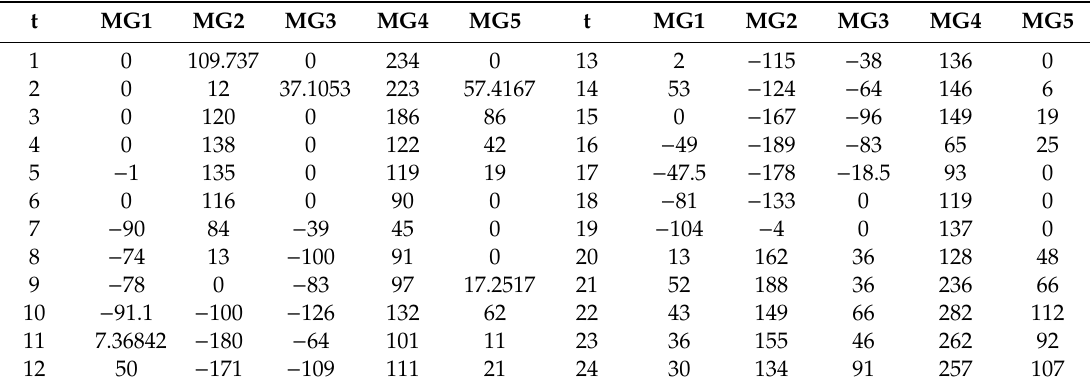
Figure 7. Local optimization results for all MGs in the network: ( a ) MG1; ( b ) MG2; ( c ) MG3; ( d ) MG4; ( e ) MG5. Table 3. Surplus/Shortage at each microgrid in kW.